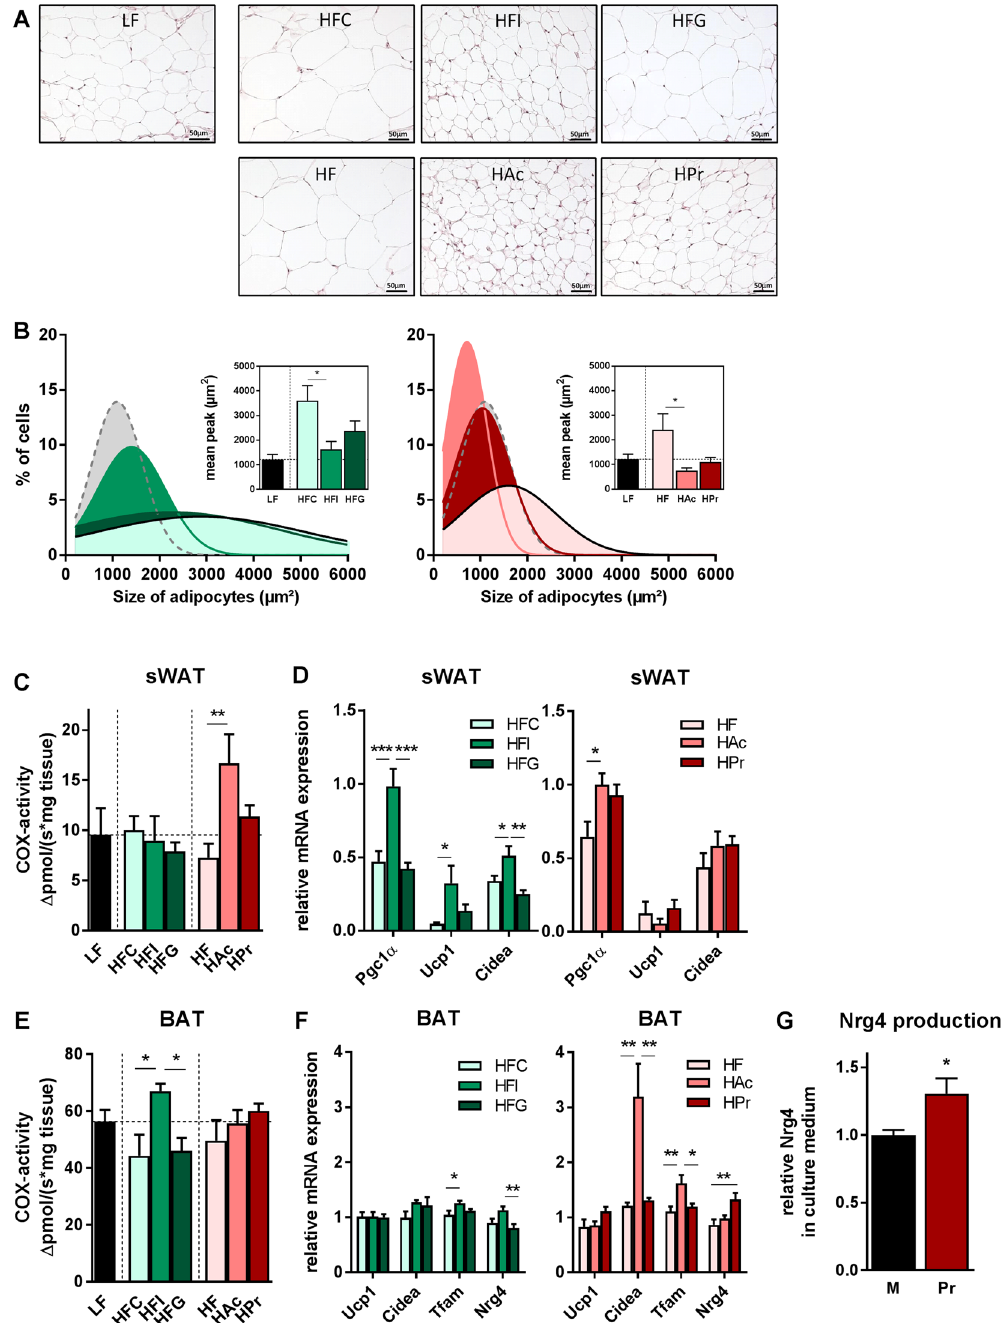
Figure 2. Inulin and SCFA reduce adipocyte size and affect adipose tissues metabolism by distinct mechanisms. Characterization of ( A – D ) subcutaneous white adipose tissue (sWAT) and ( E , F ) brown adipose tissue (BAT) of male C57BL/6JRj mice that were fed a semi-synthetic low-fat diet (LF) or high-fat diets (HF) supplemented with either 10% dietary fibre (HFC: 10% cellulose; HFI: 3% cellulose + 7% inulin; HFG: 3% cellulose + 7% guar gum; depicted in green hues) or 5% SCFA (depicted in red hues) with different Ac:Pr ratios, a high acetate (HAc; 10:1 Ac:Pr) or high propionate diet (HPr; 1:2.5 Ac:Pr) for 30 weeks. ( A ) Representative histological images of sWAT. ( B ) Adipocyte size distribution and corresponding quantification of cell size, n = 5. Measurement of cytochrome c oxidase (COX) activity in ( C ) sWAT and ( E ) BAT, n = 5. Analysis of mRNA expression in ( D ) sWAT or ( F ) BAT, normalized to LF-diet (set as 1), n = 8–9. ( G ) Relative Nrg4 secretion of primary brown adipocytes after 4 h of treatment with propionate (Pr) or without treatment (M, Media), n = 5. Data are mean + SEM, * P < 0.05; ** P < 0.01; *** P <